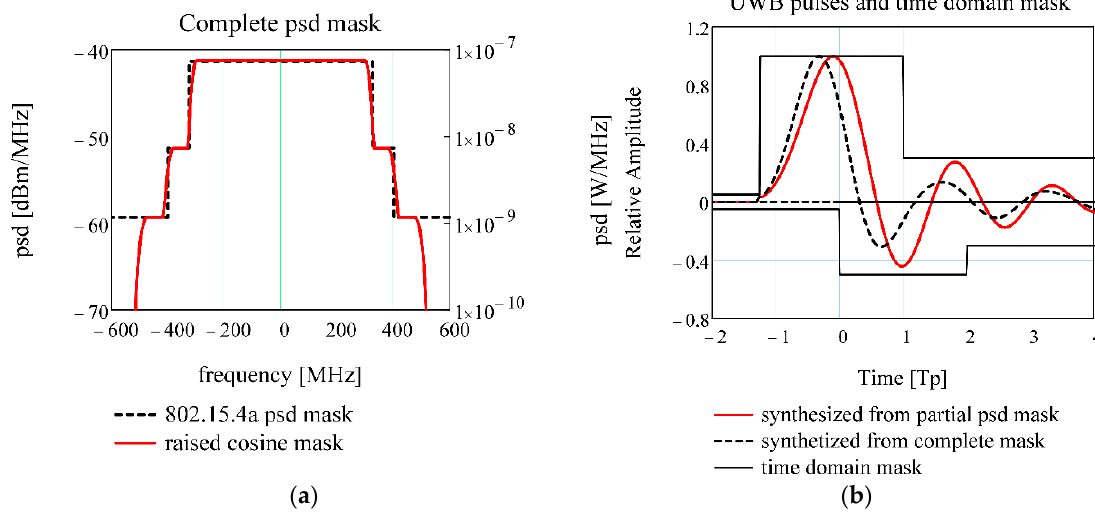
Figure 2. UWB impulse synthesis from complete spectral mask: ( a ) Spectral mask from multiple raised cosine profiles; ( b ) Time domain mask and synthesized pulses.